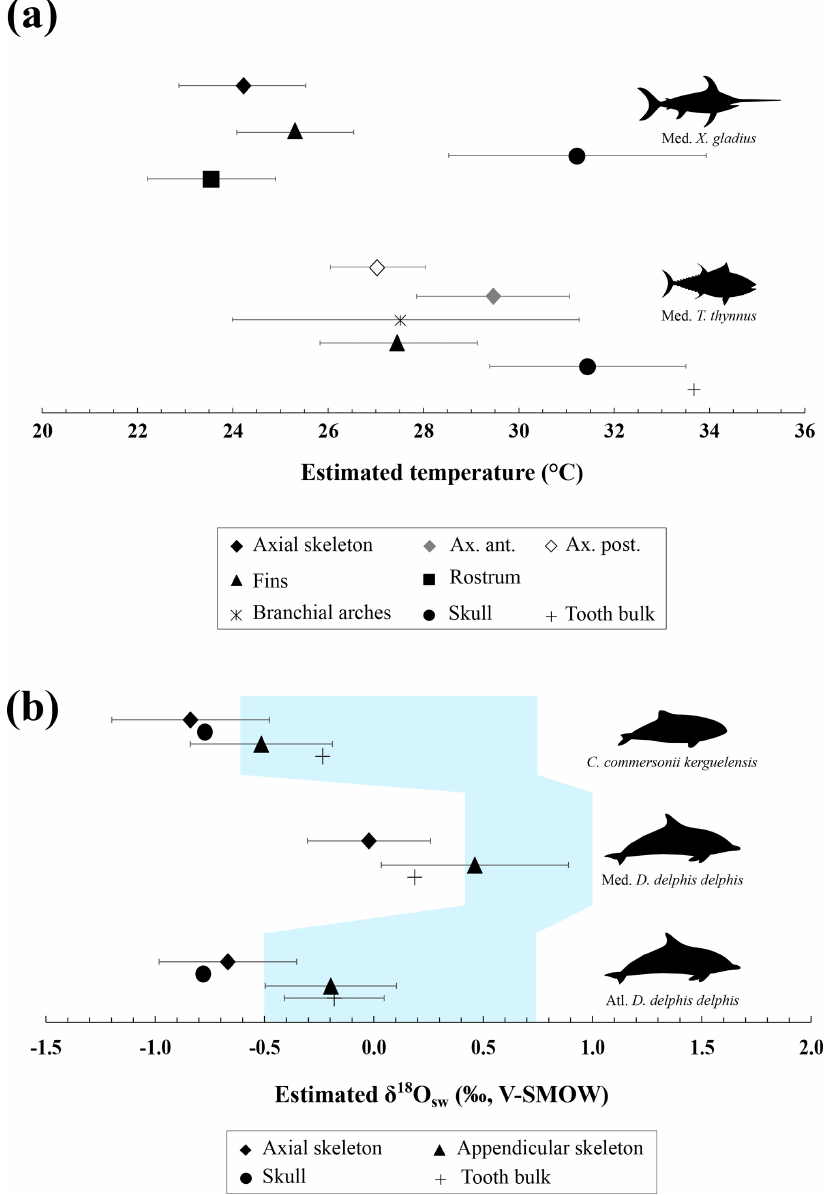
Figure 3. (a) Mean estimated hydroxylapatite mineralisation temperature from the phosphate–water oxygen fractionation equation published by Lécuyer et al. (2013), where body water oxygen isotope composition ( δ 18 O bw ) for osteichthyans is assumed to be equal to the δ 18 O sw value. Temperature estimates were done with the mean annual oxygen isotope composition of the Mediterranean Sea ( δ 18 O sw = 1.5 ± 0.4‰; Table S5). Error bars correspond to 1SD. (b) Mean estimated δ 18 O sw from the phosphate–water oxygen fractionation equation for cetaceans published by Ciner et al. (2016). Error bars correspond to 1SD and the shaded blue form corresponds to the real measured δ 18 O sw values (LeGrande and Schmidt, 2006). Abbreviations: Med. (Mediterranean Sea), Atl. (Atlantic